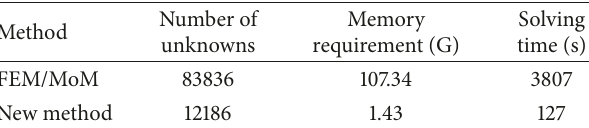
Table 1: Comparisons of the computing resource for different methods.